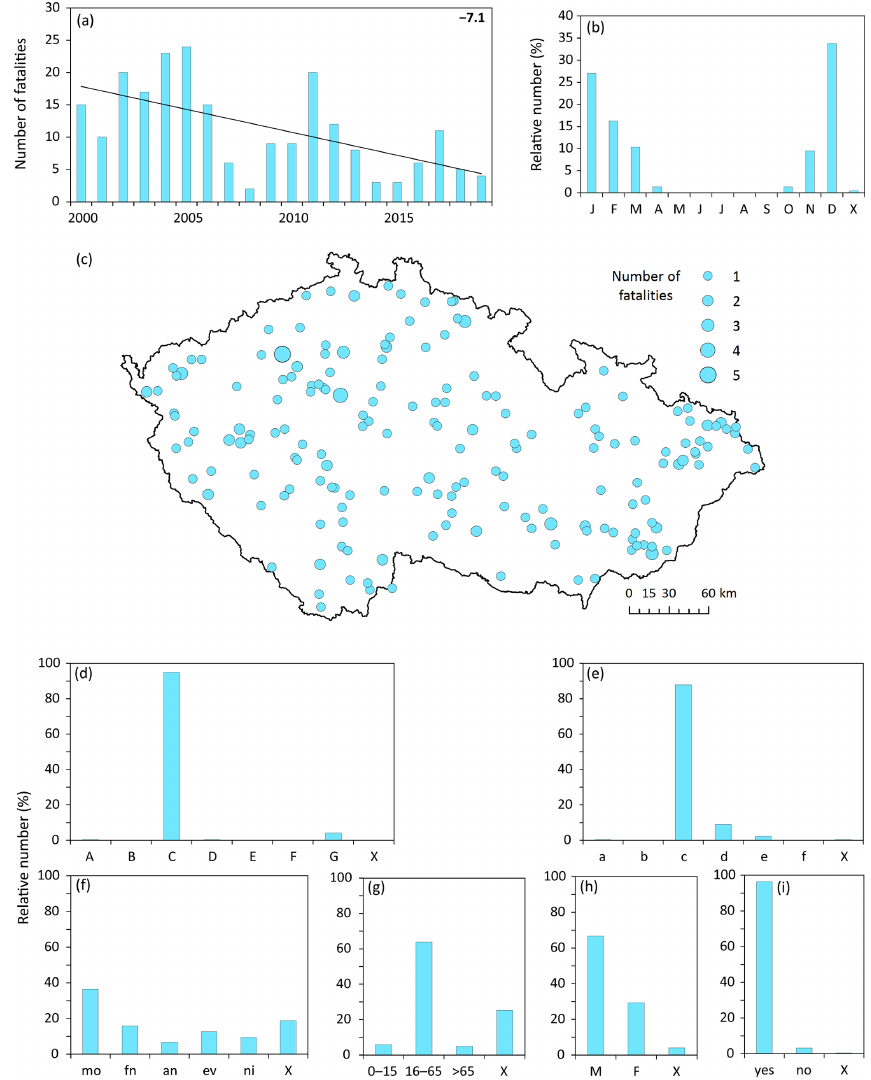
Figure 6. Characteristics of glaze-ice-related fatalities in the Czech Republic during the 2000–2019 period: (a) fluctuation with linear trend (top right, fatalities/10 years), (b) annual variation, (c) spatial distribution (eight fatalities lack exact location), (d) cause of death, (e) place of death, (f) part of the day, (g) age, (h) sex, (i) behaviour. For explanation of symbols and abbreviations see Fig.